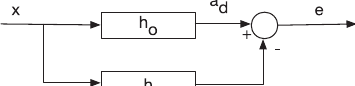
d and the signal